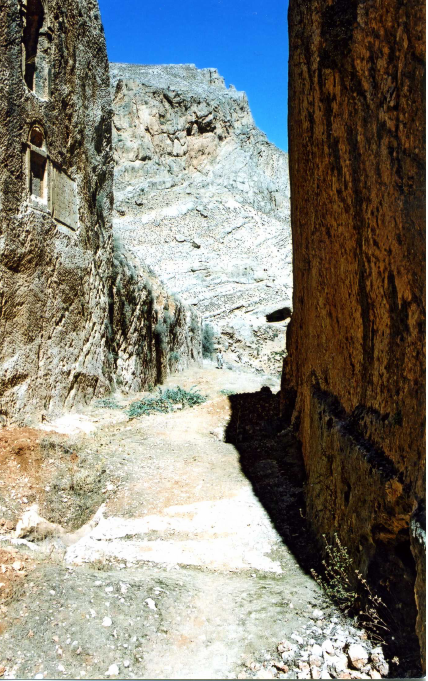
Figure 3. Rock-cut Roman road in Wadi Barada near Damascus in